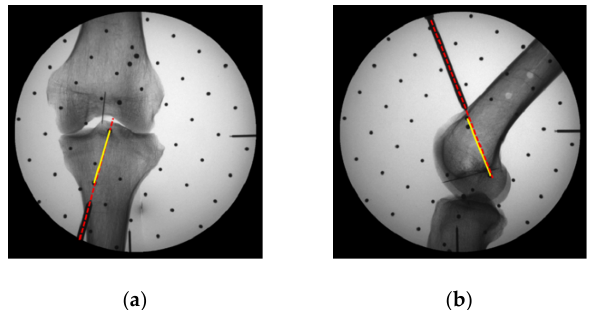
Figure 17. X-Ray images of positioning of the tunnels, planning tunnels through 2 steel balls was marked in yellow line and positioning tunnel was marked in red line: ( a ) Tibia planning tunnel; ( b ) Femoral planning tunnel. Table 2. Positioning Errors of the navigation system for ACL reconstruction.